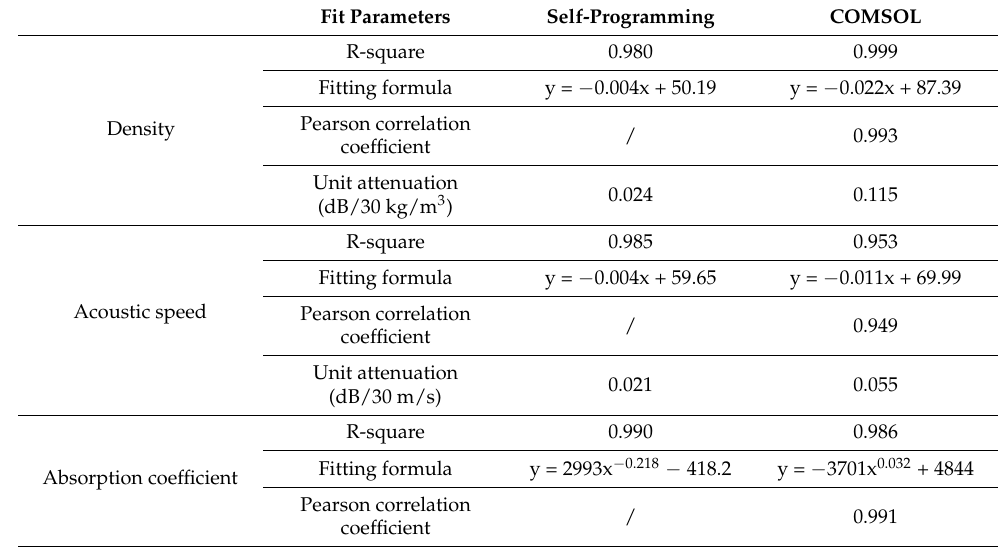
Table 4. Acoustic parameters fitting